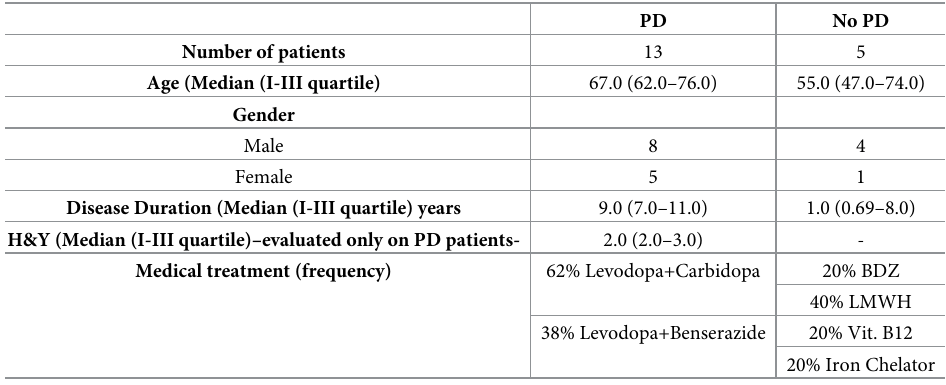
Table 1. Demographic and clinical characteristics of PD and No-PD groups.